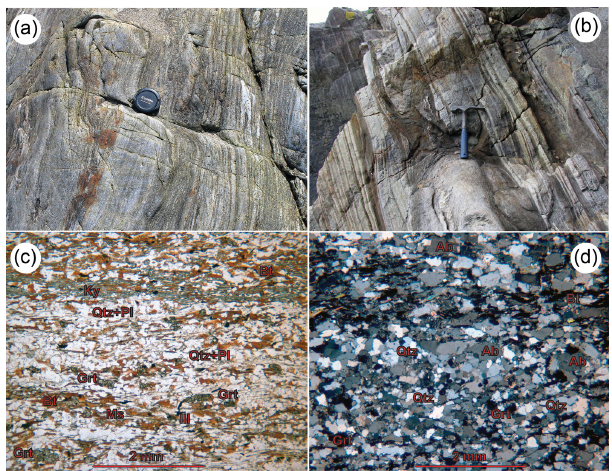
Figure 7. Metasedimentary qz-fsp gneisses and related rocks. (a) Leucosome veins (to right of the scale marker) parallel to the compositional banding. (b) Intrafolial folds related to the S 2 folia- tion superimposed on the compositional banding. (c) Microphoto- graph of a metapelite band (sample B1427). (d) Microphotograph of a metapsammite band (sample B22). Sample locations are in Fig.